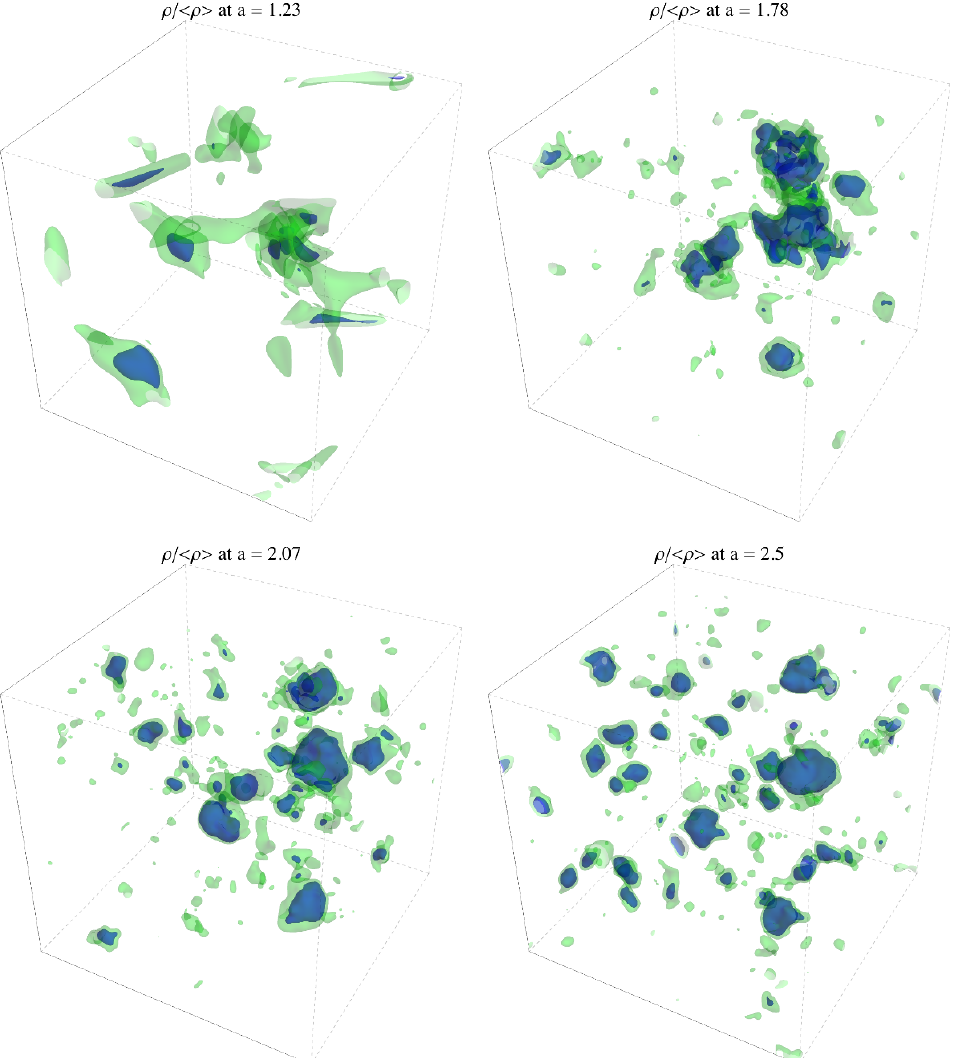
Figure 13 . Three dimensional energy density distribution in units of the average energy density. The green surfaces correspond to overdensities six times the average energy density, while the blue ones correspond to twelve times the average energy